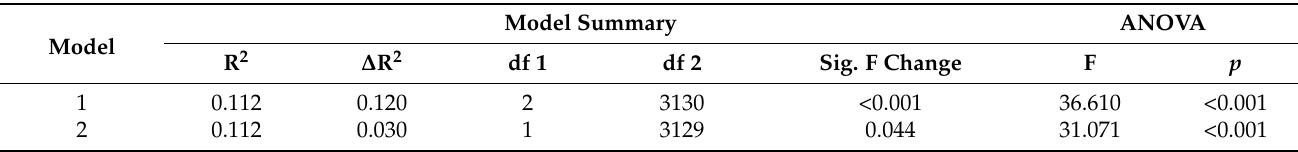
Table 5. Summary of the results of the moderating